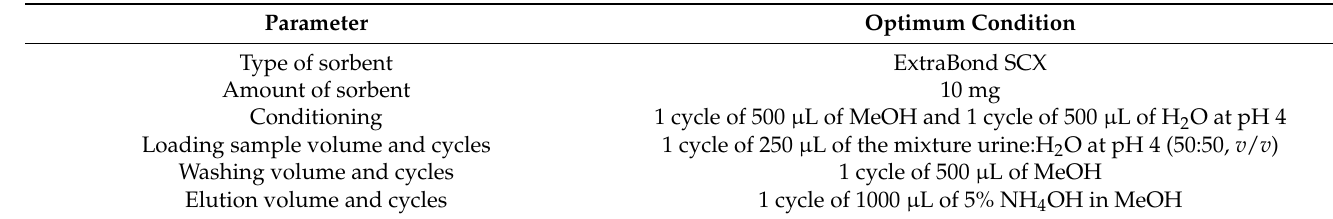
Table 1. Extraction conditions of the PT-SPE procedure for the determination of 40 DOAs in urine by